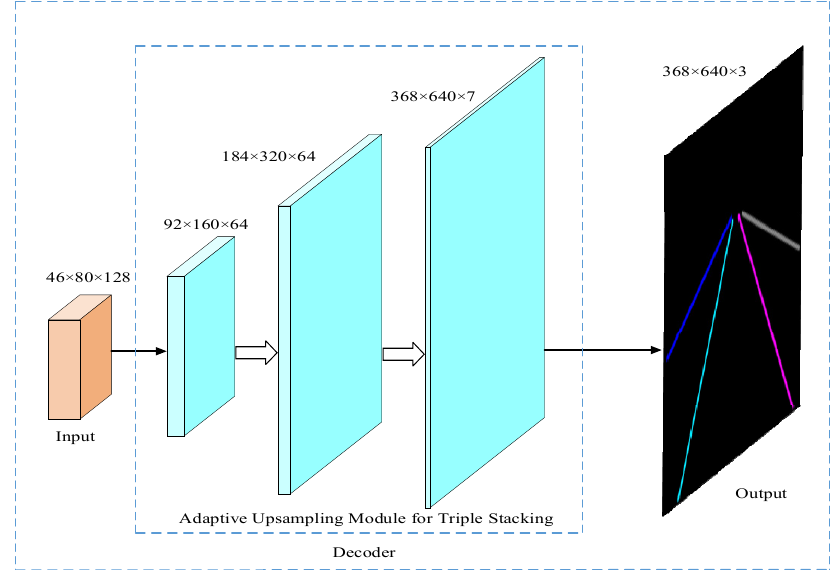
Figure 6. Decoder network structure.